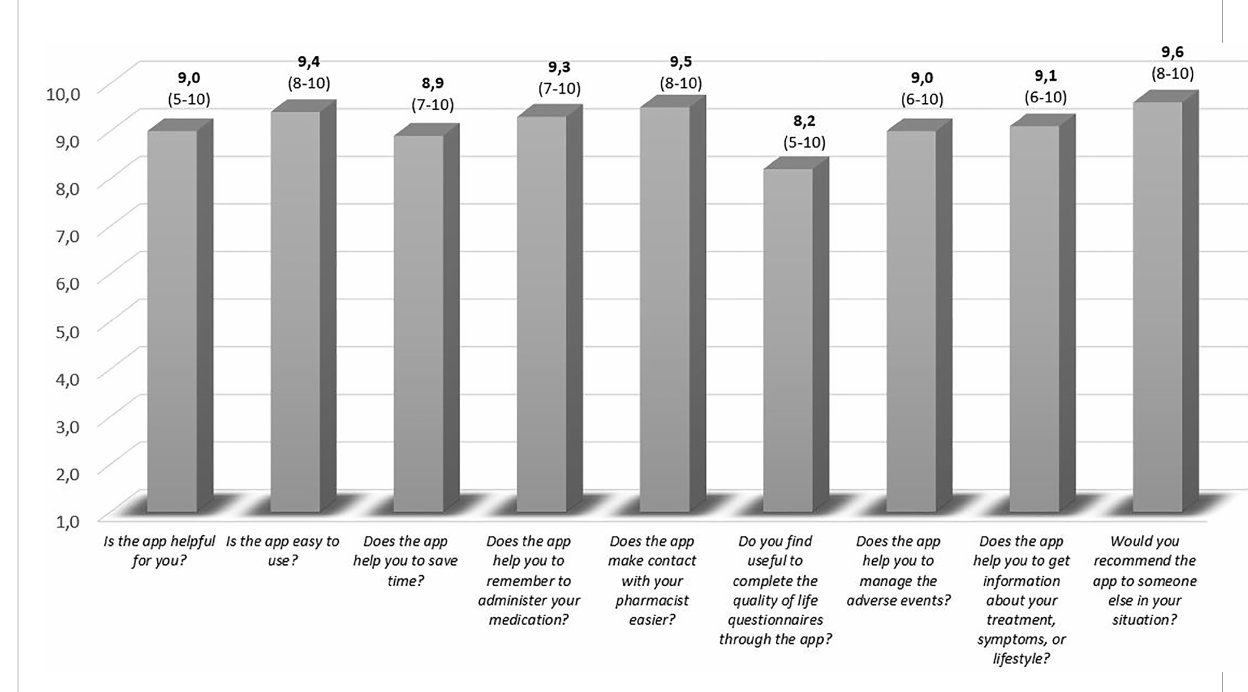
FIGURE 3 Patient satisfaction with eMidCare ® . The score is expressed as the median